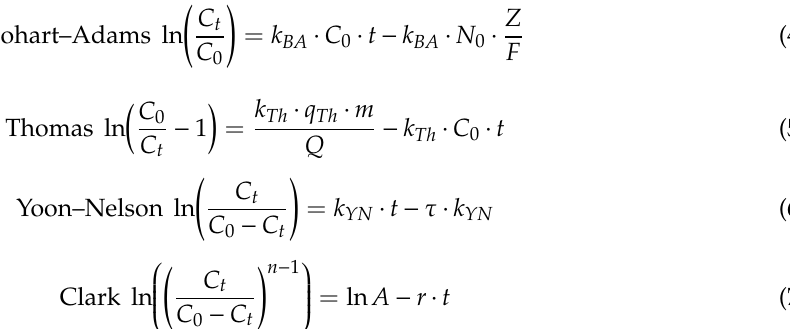
Figure 4. Energy dispersive X-ray (EDX) spectra for MgSiO 3 and MgSiO 3 -cys materials. Figure 5. The FTIR spectra for commercial magnesium silicate and functionalized MgSiO 3 -cys.